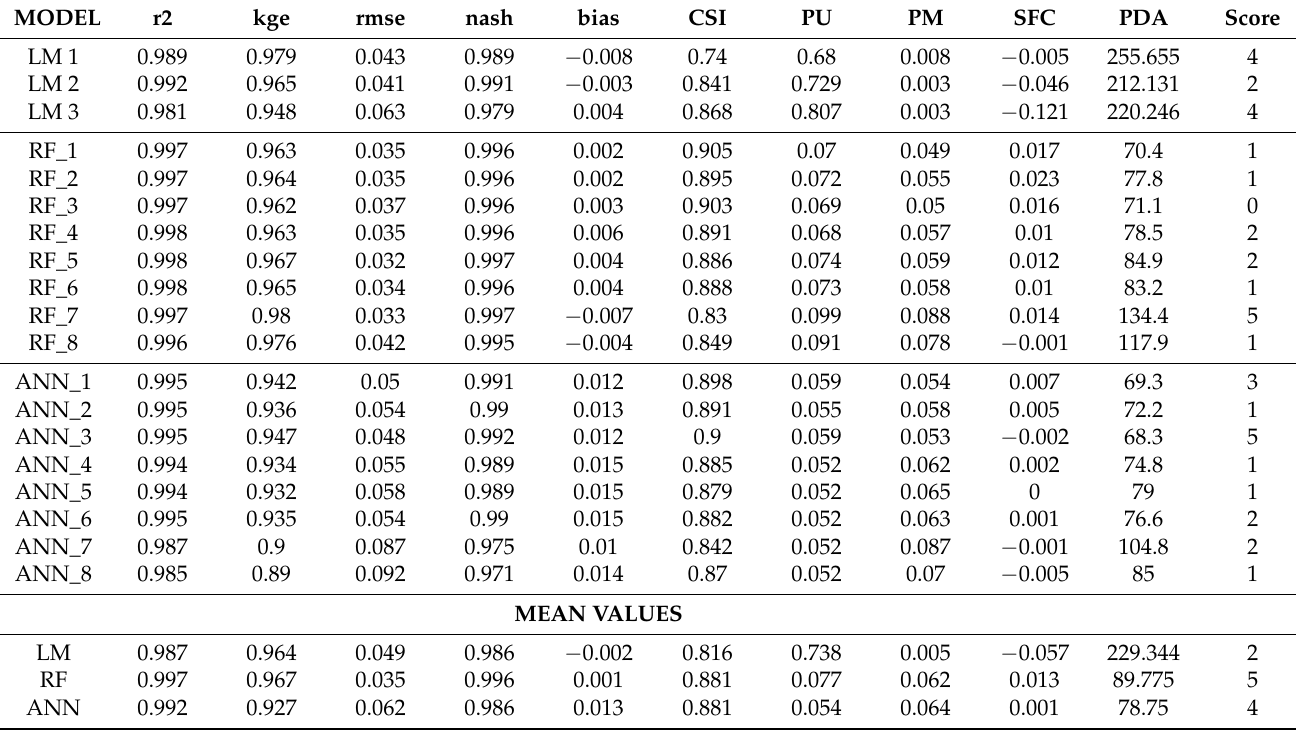
Table 7. Metrics for LM, ANN, and RF models. Fraction quantification and detection metrics are in lowercase and uppercase,